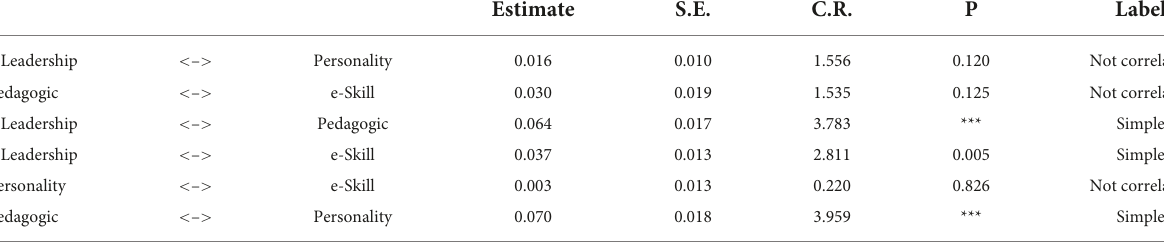
TABLE 10 Covariances: (Group number 1—Default model).